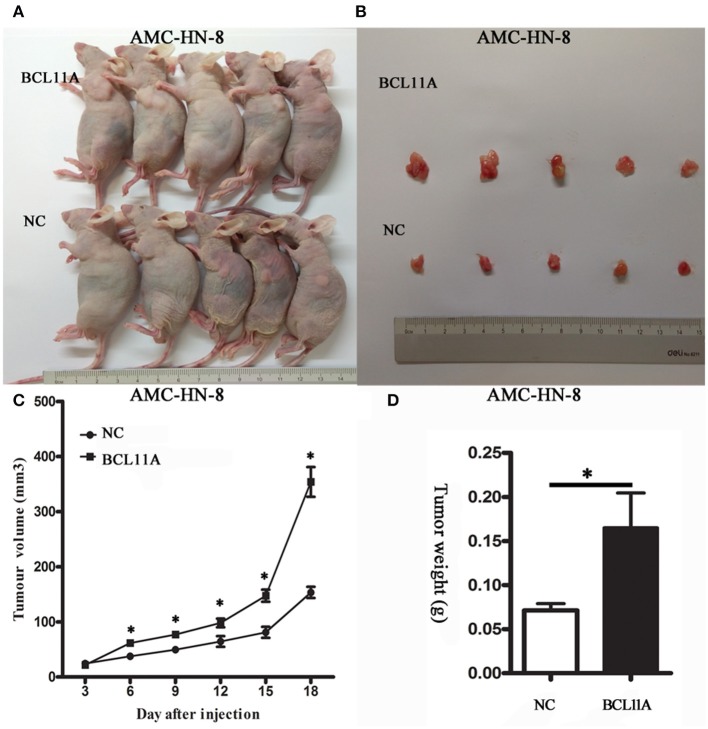
BCL11A regulated AMC-HN-8 cell growth in vivo. (A) Images of mice with xenograft tumors of BCL11A-overexpression AMC-HN-8 cells and the control cells (NC); (B) Image of tumors isolated from nude mice. (C) Growth curves of the xenografts in the BCL11A-overexpression AMC-HN-8 cell group and control cells (NC) (n = 5, mean ± SEM). (D) Comparison of the weight of the xenografts in the BCL11A-overexpression AMC-HN-8 cells and control cells (NC) harvested 18 d after injection of the cells (n = 5, mean ± SEM). *P < 0.05.